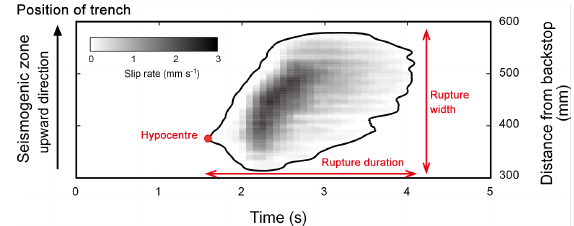
Figure 14. Rupture dynamics as observed in the subduction zone megathrust models of Corbi et al. (2013): slip evolution of a crack- like analogue subduction megathrust earthquake propagating up- wards and downwards in the seismogenic zone (modified from Corbi et al.,